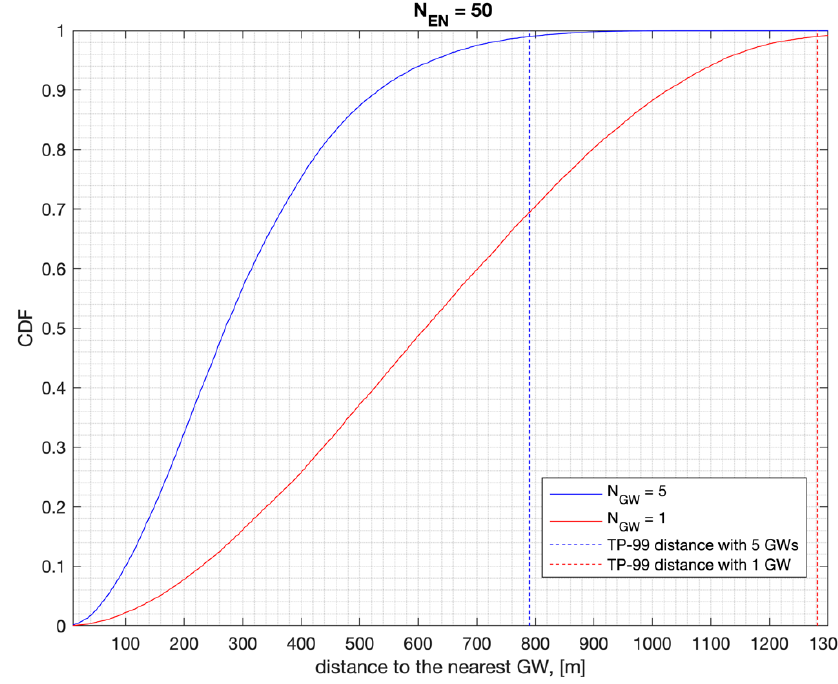
Figure 12. The CDF of distance to the nearest GW with 50 ENs .